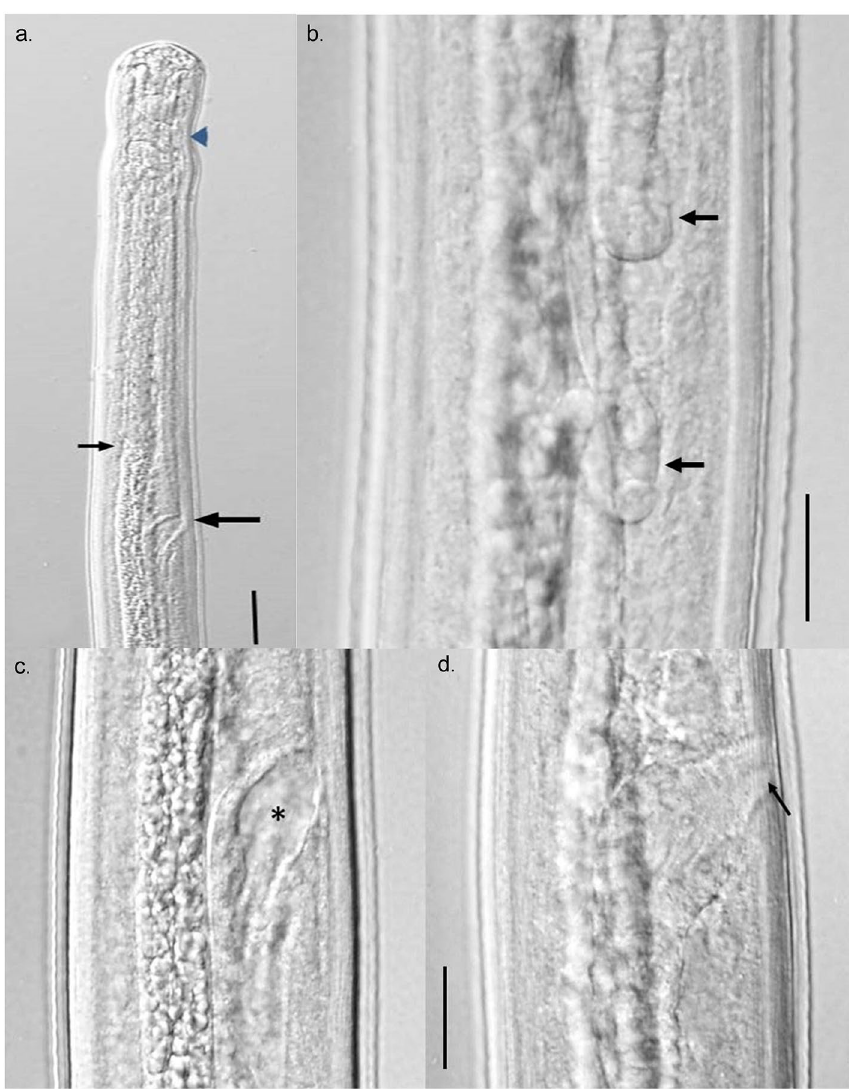
Figure 2. Differential Interference Contrast microscopy image of female larva recovered from NSG mice at 15 weeks post infection. ( a ) Anterior end showing nerve ring (arrow head), junction of esophagus and intestine (small arrow), and ovijector (large arrow). Scale bar 50 µm. ( c , d ) Composite image of ovijector, ( c ) hollow cavity (asterisk) and posteriorly directed vagina. Scale bar 20 µm. ( d ) Narrow, muscular vulva (arrow) attached to body wall. ( b ) Paired coiled ovaries in the posterior quarter of the body (arrows). Scale bar 20